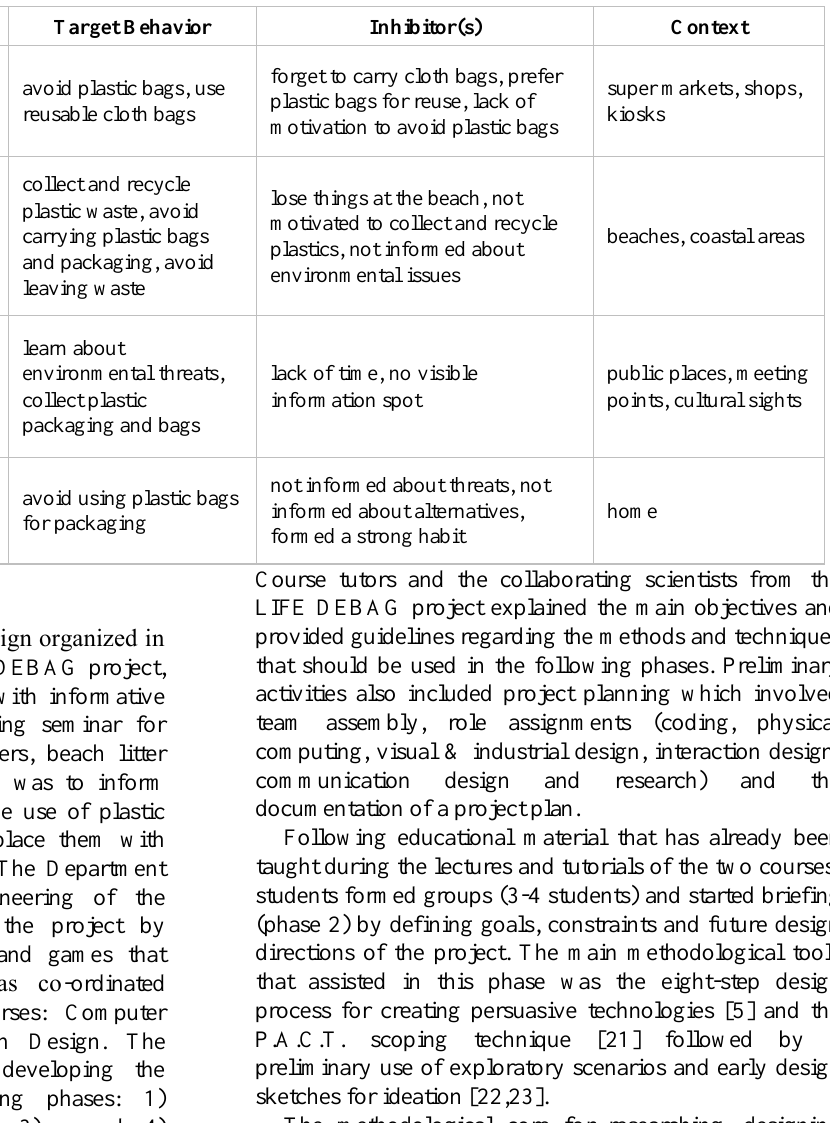
Table 1. People, activities, target behavior and inhibitors in four different